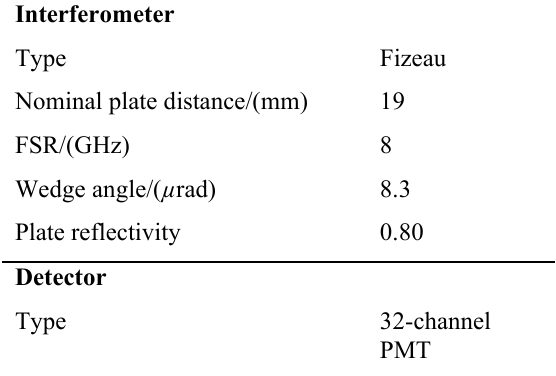
Table 1. Parameters of the Fizeau interferometer Interferometer